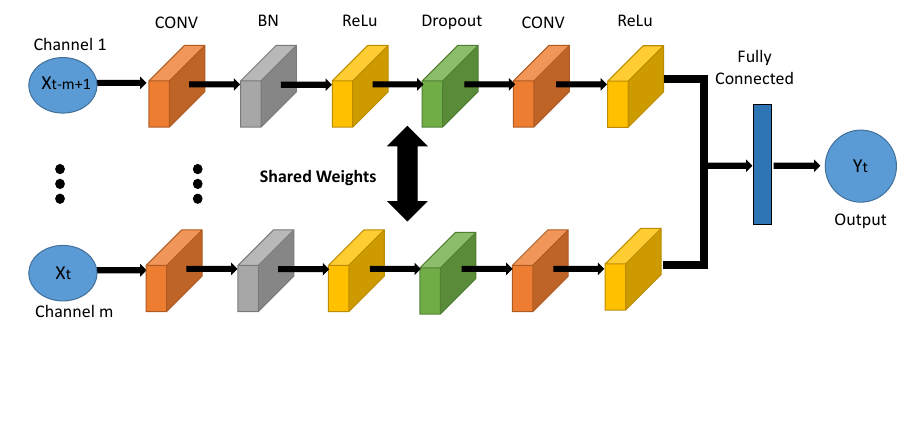
Figure 2. Illustration of the CNN based